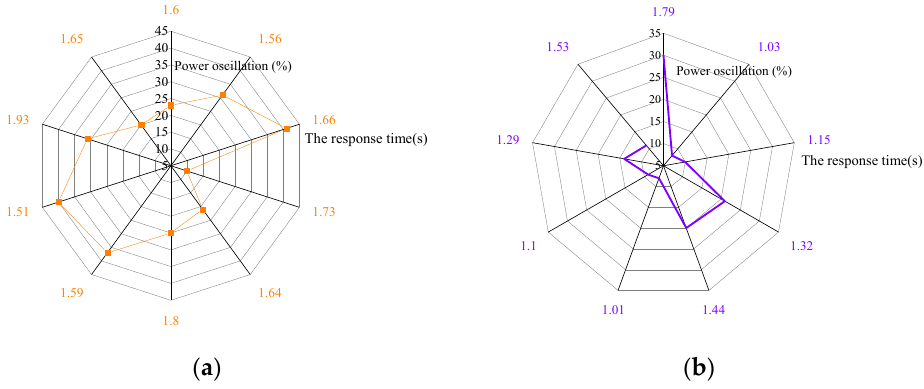
Figure 10. Experimental results of the tracking time and tracking oscillation of the PSO algorithm: ( a ) before improvement; ( b ) after improvement. Table 4. Experimental results of the PSO tracking time and tracking oscillation.